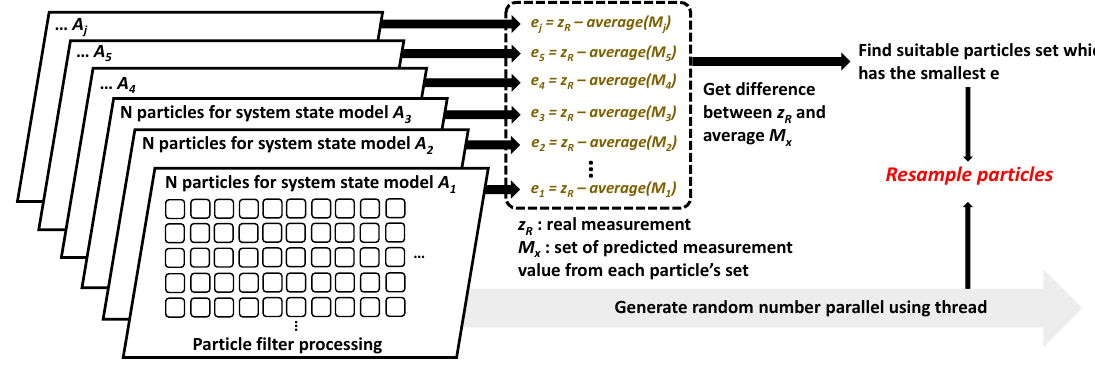
Figure 6. PF using multiple state-space models in